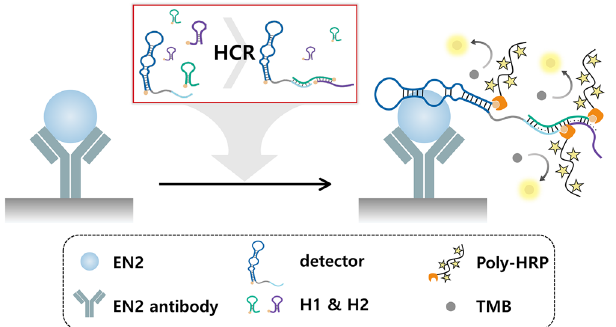
Figure 1. Schematic illustration of the HCR-based aptamer-antibody hybrid ELONA for